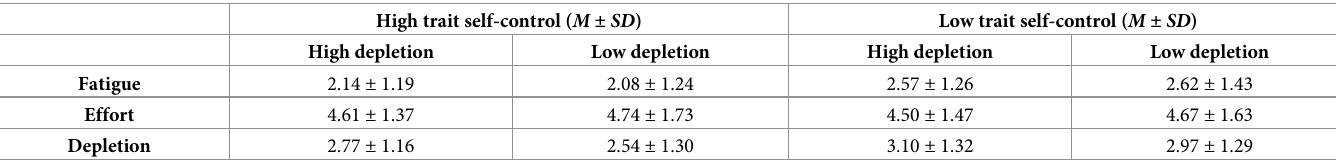
Table 3. Descriptive statistics of the degrees of fatigue, effort and depletion.